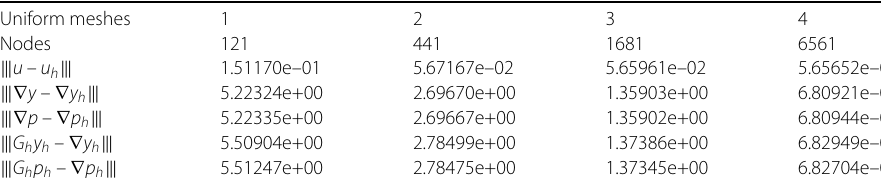
Table 2 Numerical results on uniform meshes, Example 2